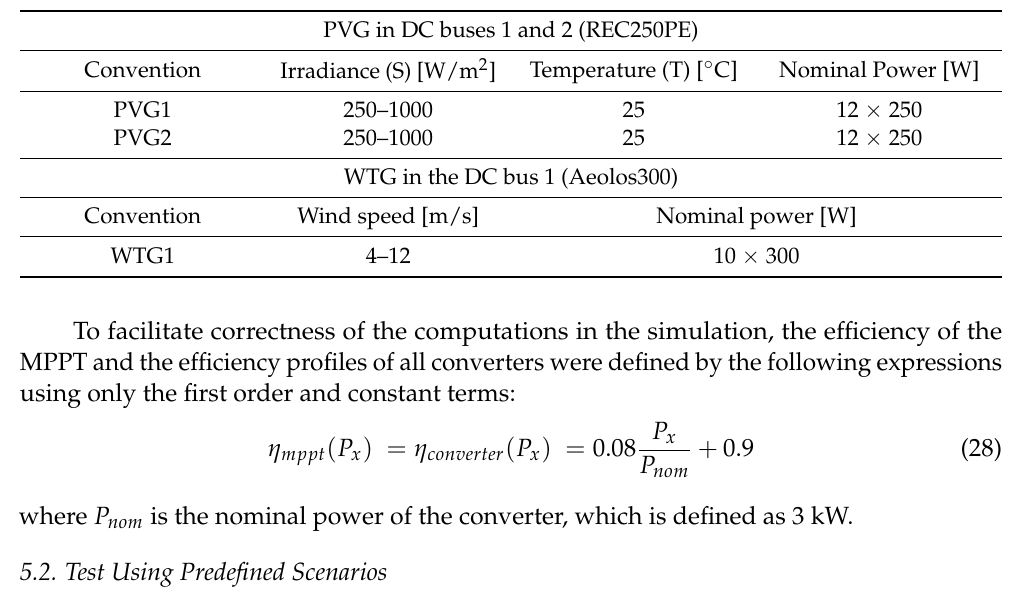
Table 8. Parameters used in simulation tests.